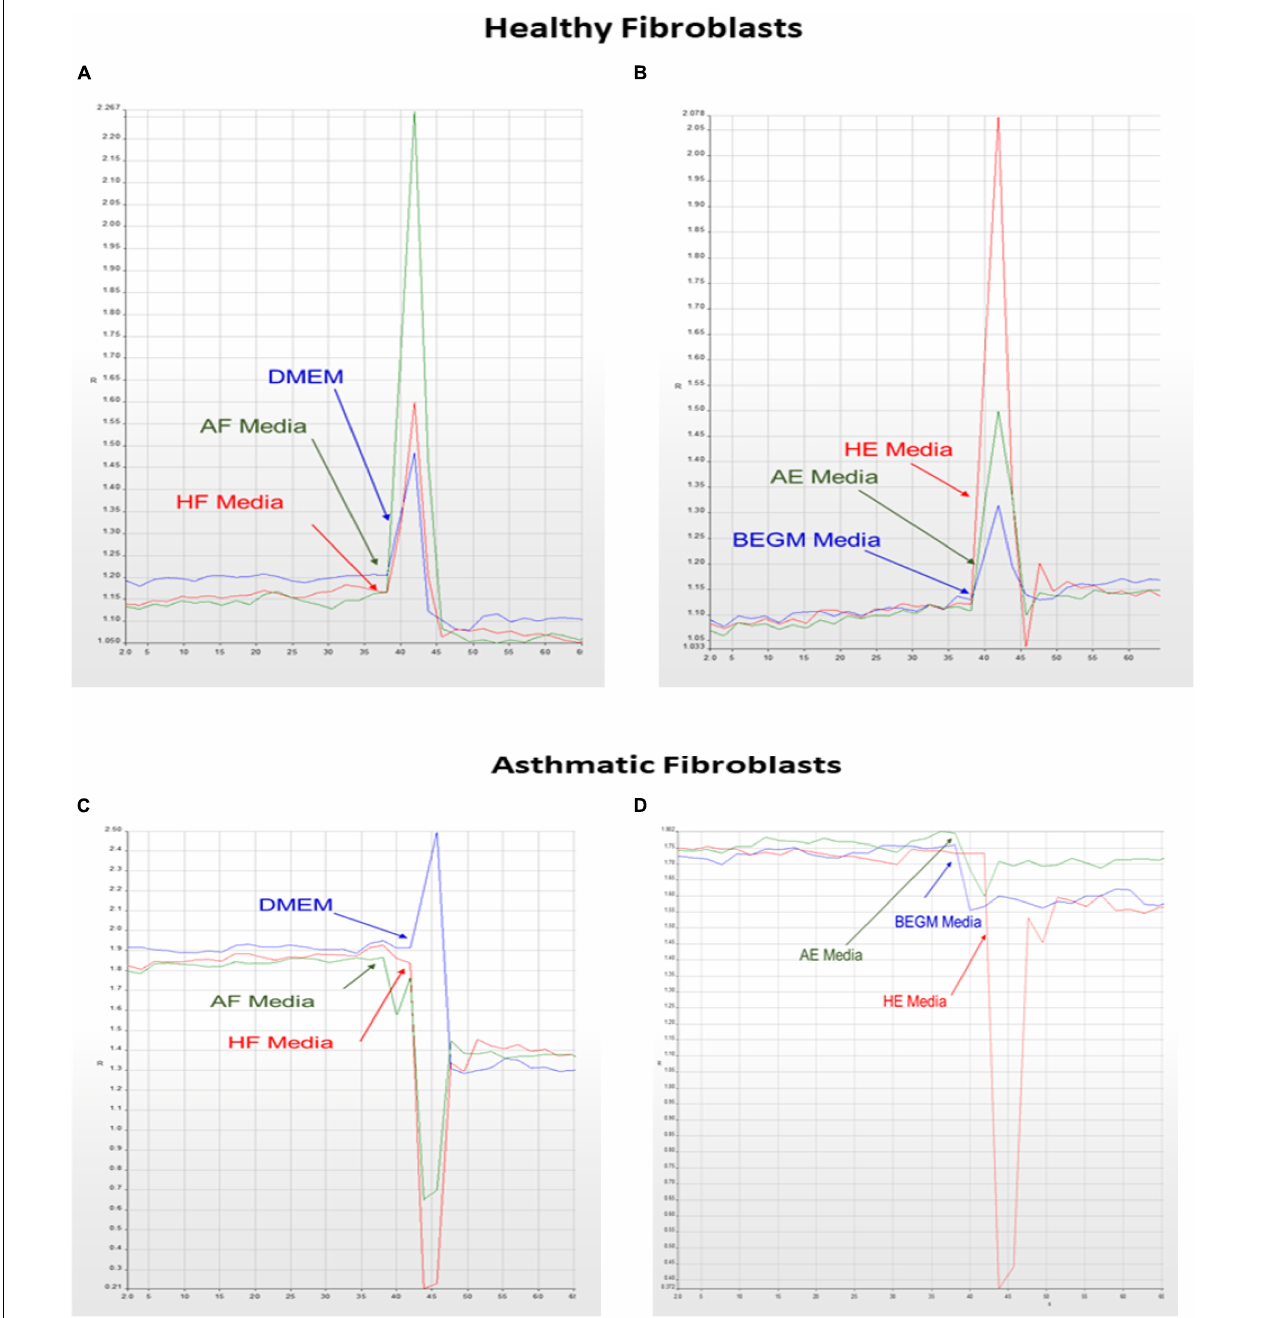
FIGURE 8 | Calcium mobilization in healthy and asthmatic bronchial fibroblasts in response to healthy and asthmatic fibroblast and epithelial supernatants. A Fura-2-AM-labeled healthy and asthmatic bronchial fibroblast cells were stimulated with 24-h undiluted supernatants collected from healthy (H) and asthmatic (A) bronchial fibroblasts (F) and epithelial cells (E), HF, AF, HE, and AE. The results were compared to media only (DMEM for fibroblasts and BEGM for epithelium). Calcium mobilization was determined by measuring the ratio of F340/380. (A) HF treated with HF, AF, and Media (B) HF treated with HE, AE, and Media (C) AF treated with HF, AF, and Media (D) AF treated with HE, AE, and